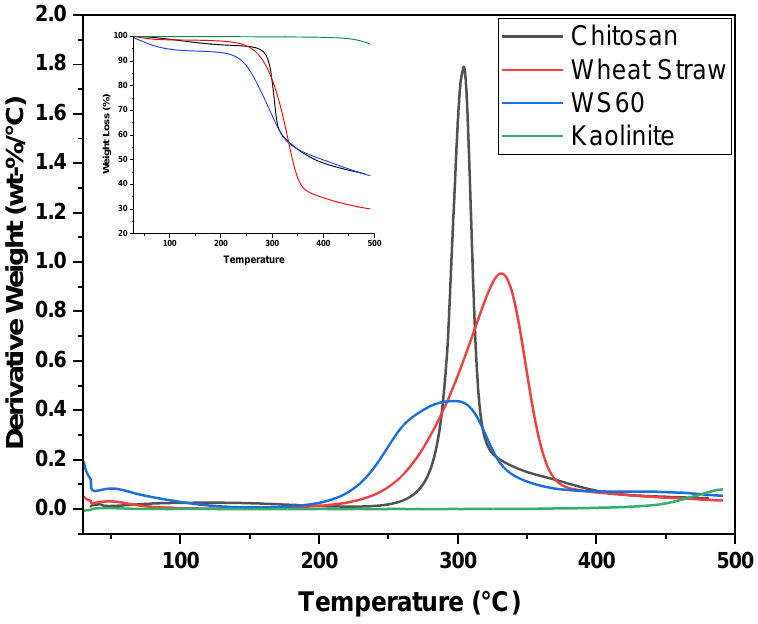
Figure 3. Differential thermal analysis (DTG) of chitosan, kaolinite, torrefied wheat straw and the WS60 ternary composite material. Normalized TGA profiles are provided for reference in the inset.